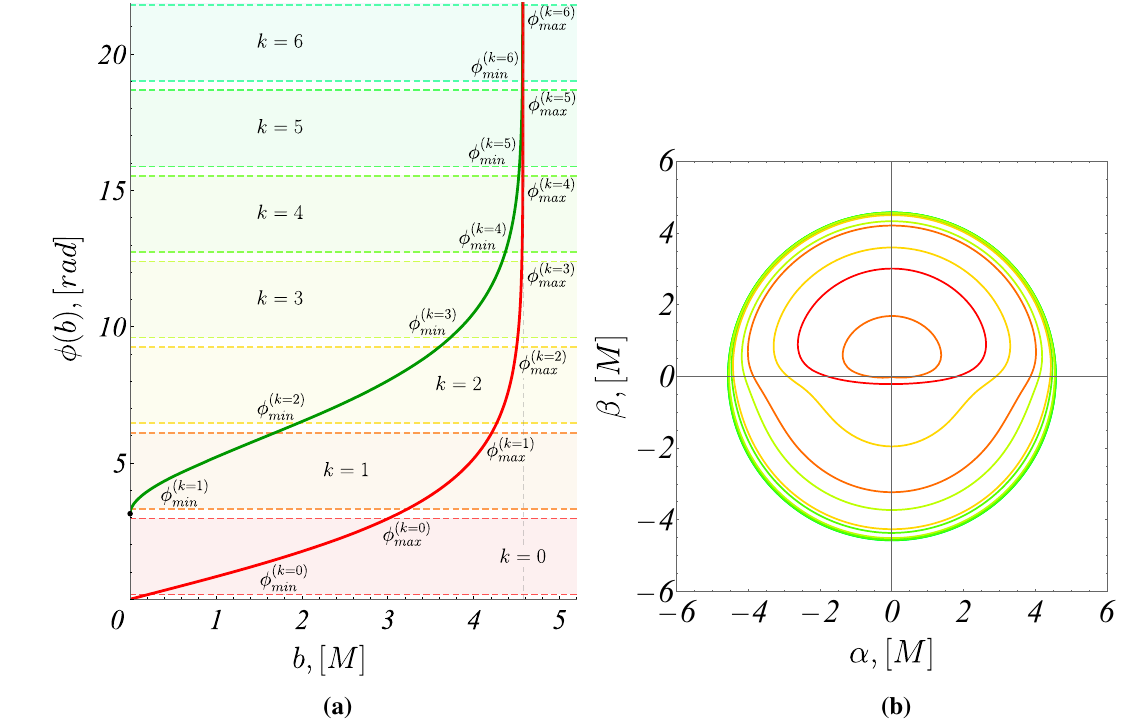
Fig. 7 Imageformationdiagramforacircularorbitfromtheinnerdisk ( a ), and the corresponding observable image ( b ). The orbit is located at the radial coordinate r = 1 . 227 M , while the observer’s position is